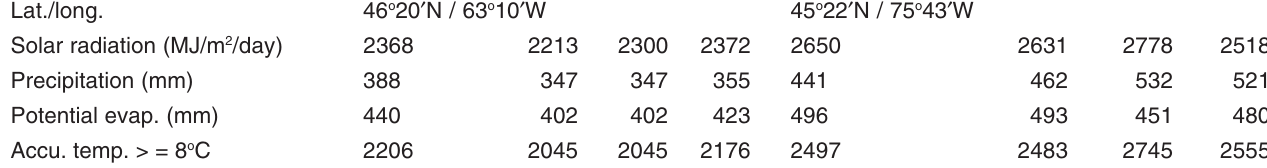
General Conditions of Field Experiments in Two Different Locations Soybean (Harrington, PEI) Maize (Ottawa)